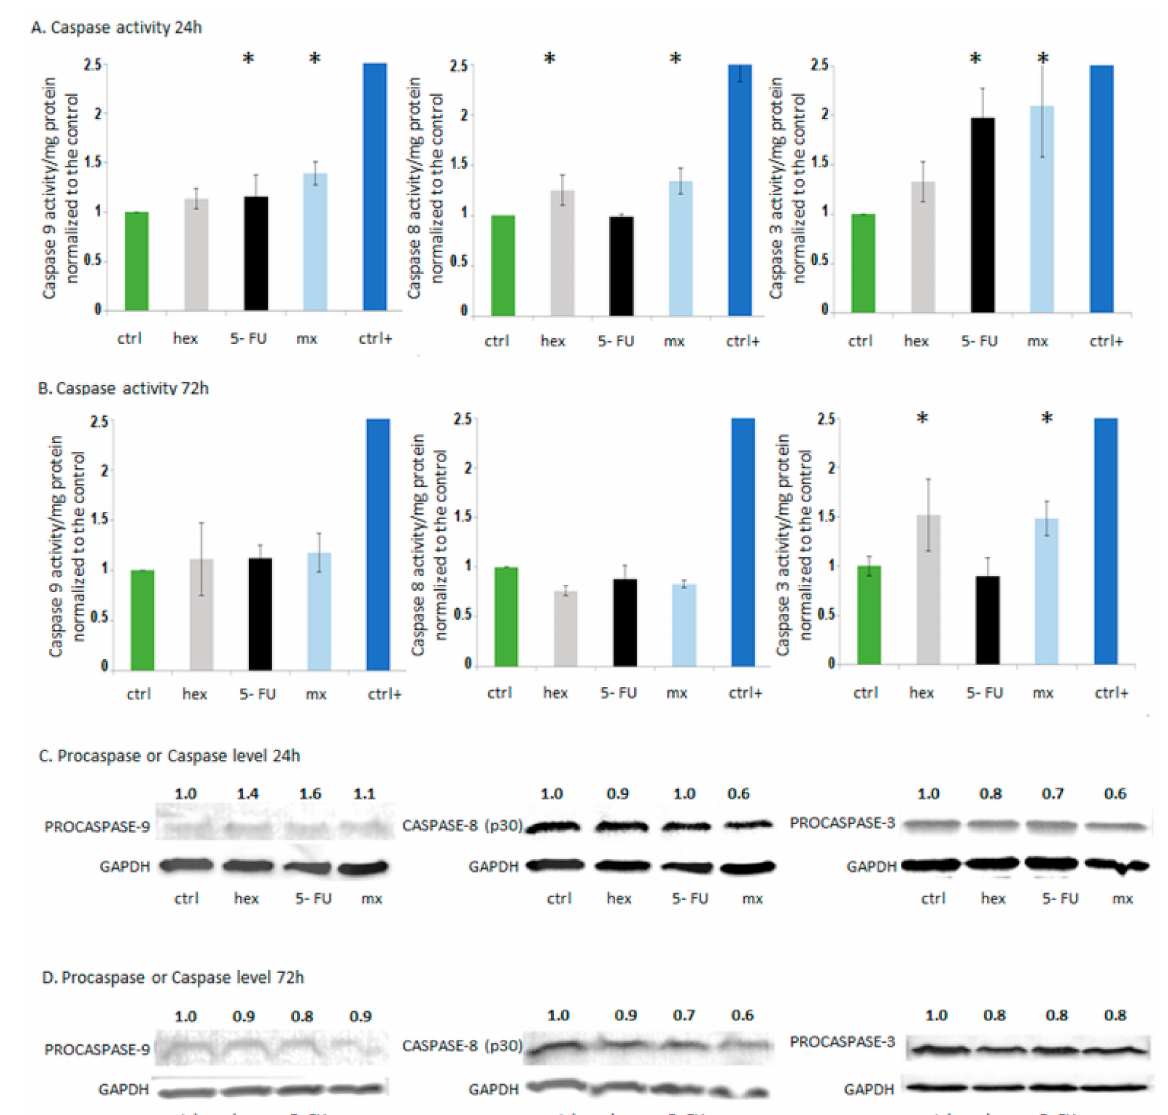
Figure 4. Apoptosis studies. ( A ) Caspase (Caspase 9, Caspase 8, and Caspase 3) activity/mg protein normalized to the control (ctrl) after the combined 5-FU and 2-oxohexyl ITC treatment, individual 5-FU treatment, individual hex treatment, and positive control treatment (ctrl+) after 24 ( A ) and 72 h incubation ( B ). * Statistically significant difference from the control; p < 0.05. Changes in the levels of apoptosis-related proteins obtained by Western blotting after the administration of individual compounds, the combined treatment of 5-FU with hex, and for the control cells (ctrl) after 24-h incubation ( C ) and after 72-h incubation ( D ). Glyceraldehyde-3-phosphate dehydrogenase (GAPDH) was amplified as an internal control. The results of the bands of procaspase forms were quantified by densitometric analysis, and their intensity was normalized with respect to